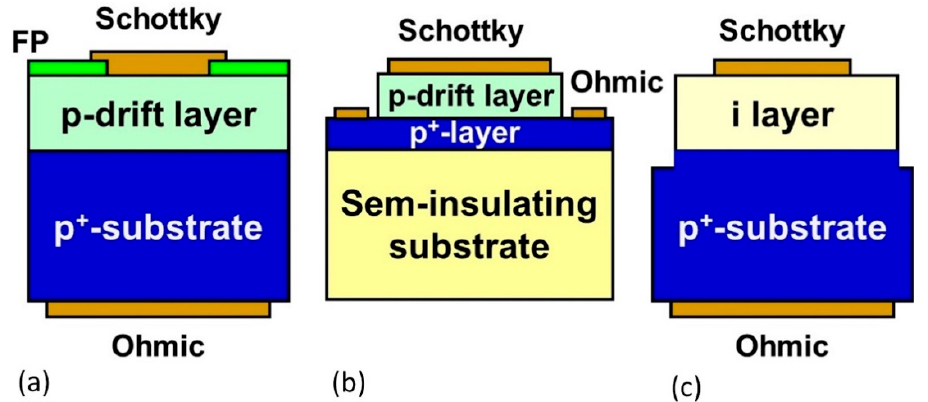
Figure 7. Schematic illustrations of vertical-type diamond Schottky barrier diodes. ( a ) Vertical SBD. ( b ) Pseudo-vertical SBD. ( c ) Metal-intrinsic